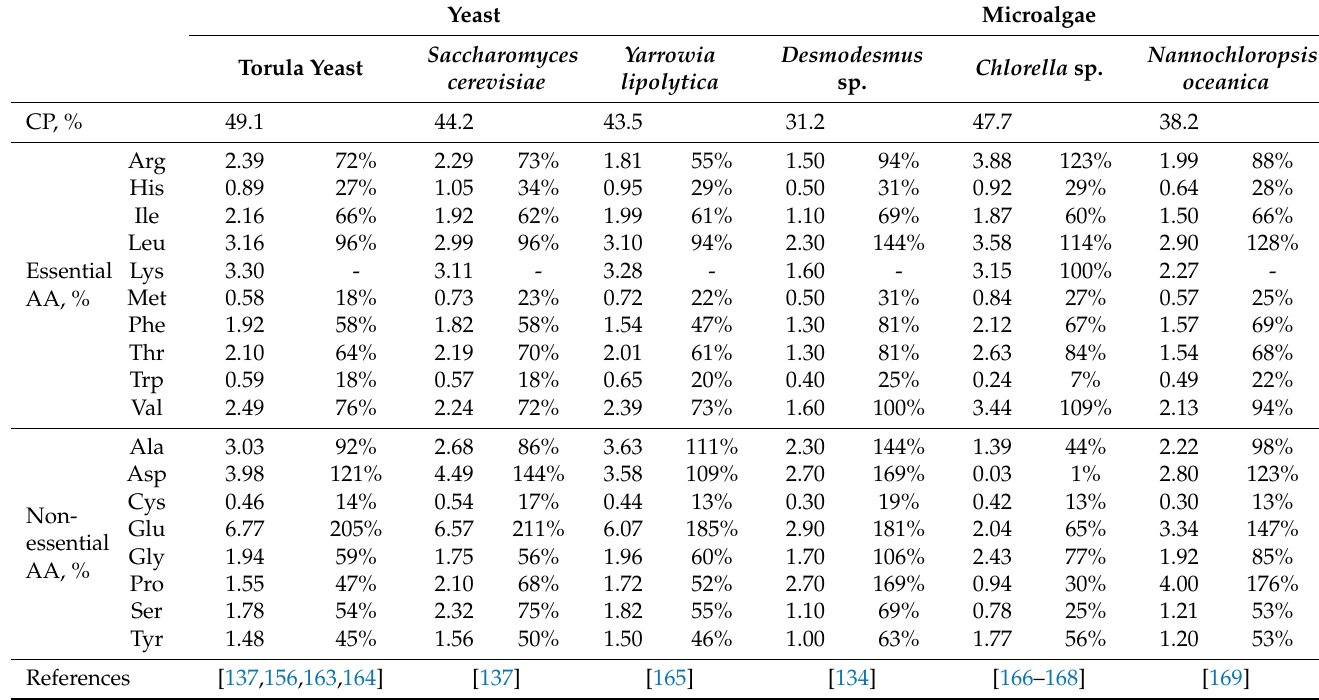
Table 6. Composition of crude protein (CP) and amino acids (AA-to-lysine ratio) of single-cell protein from yeasts and microalgae.